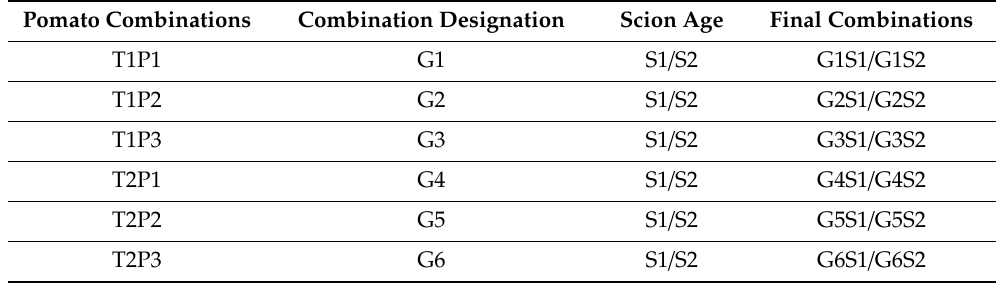
Table 2. Graft combinations of pomato plants. The potato varieties were Diamant (P1), Cardinal (P2) and Asterix (P3), and the tomato varieties were BARI tomato-2 (T1) and BARI tomato-11 (T2). The graft combinations were T1P1 (G1), T1P2 (G2), T1P3 (G3), T2P1 (G4), T2P2 (G5) and T2P3 (G6). Tomato seedlings aged 25 (S1) and 35 days (S2) were selected as